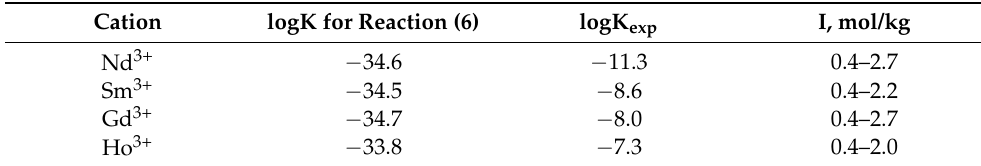
Table 3. Equilibrium constants in carbonate–alkaline